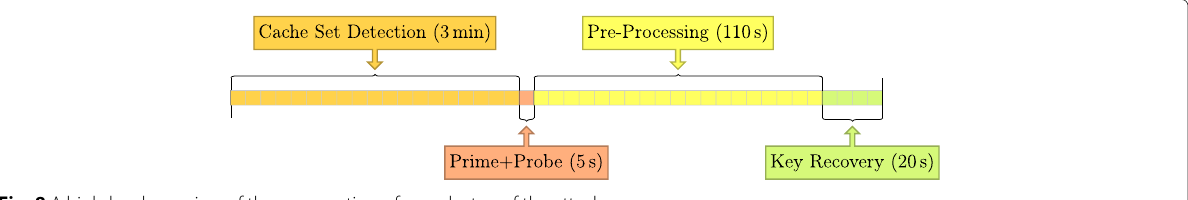
Fig. 8 A high-level overview of the average times for each step of the attack